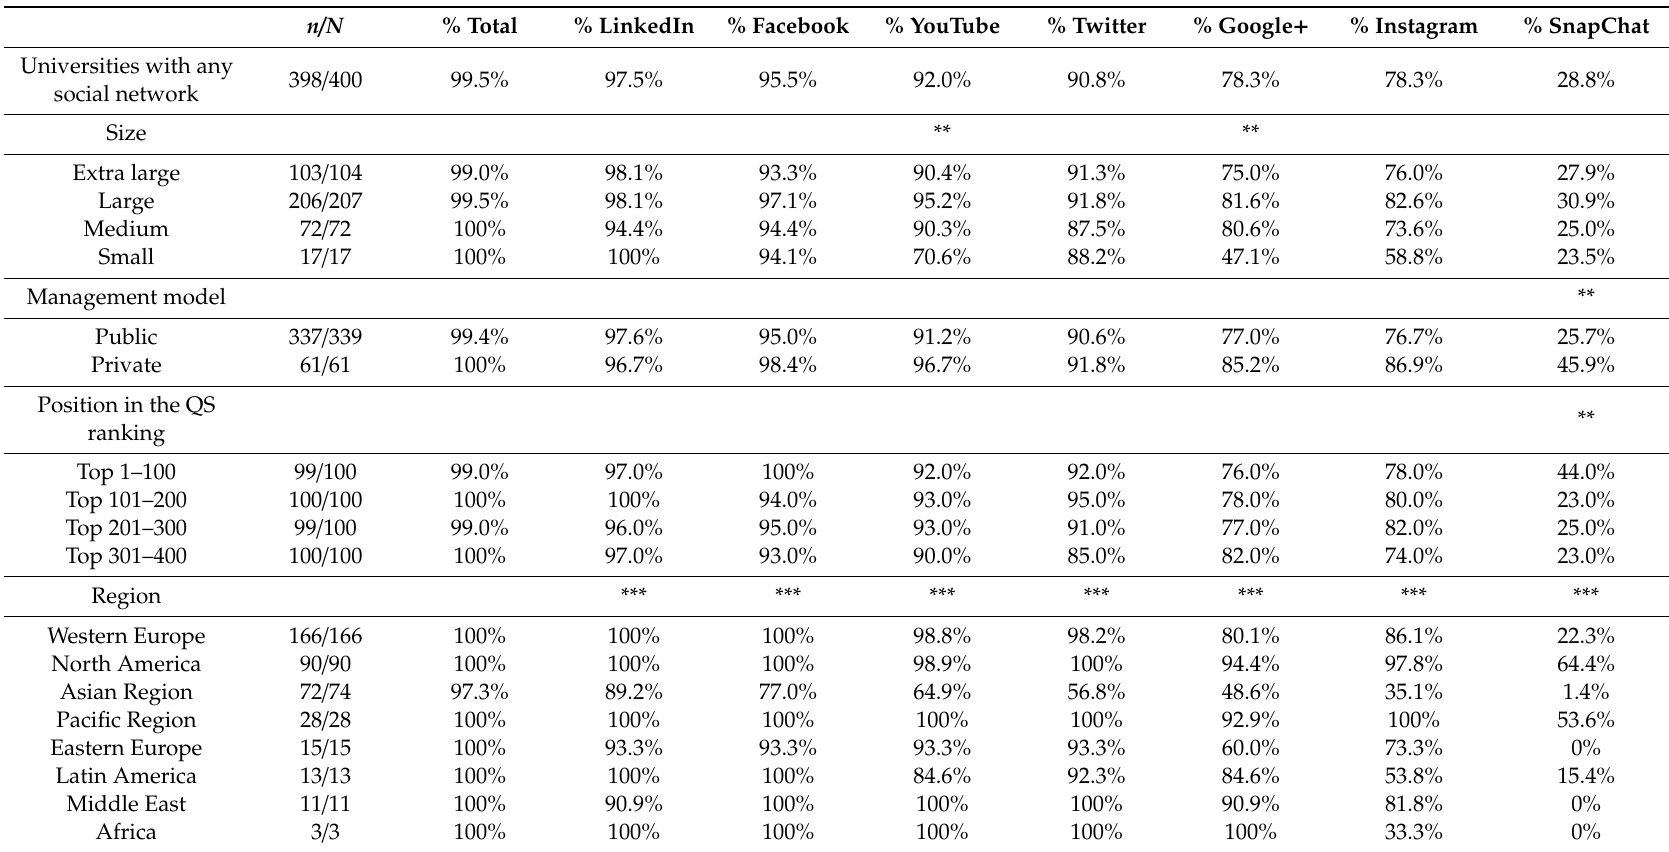
Table 1. Presence of o ffi cial accounts on seven social networking